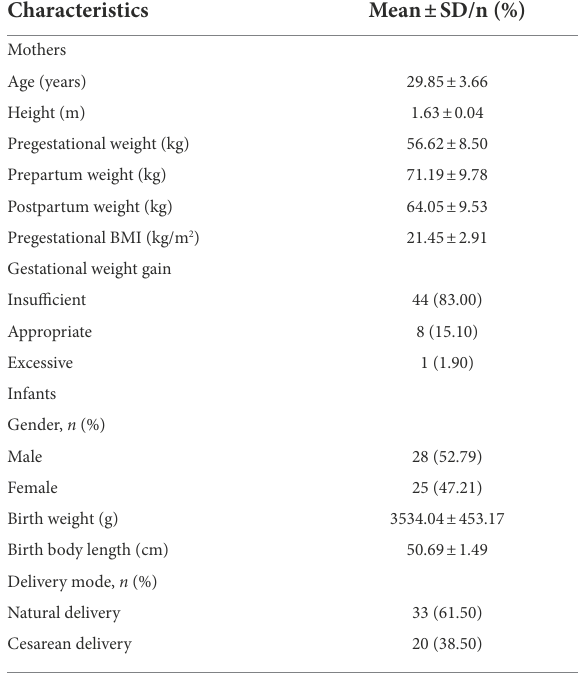
TABLE 2 Baseline characteristics of participants and infants ( n =